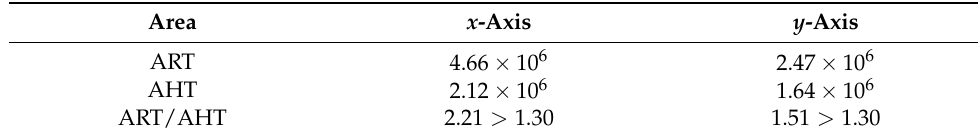
Table 4. Area under torque curve data for the operating condition.